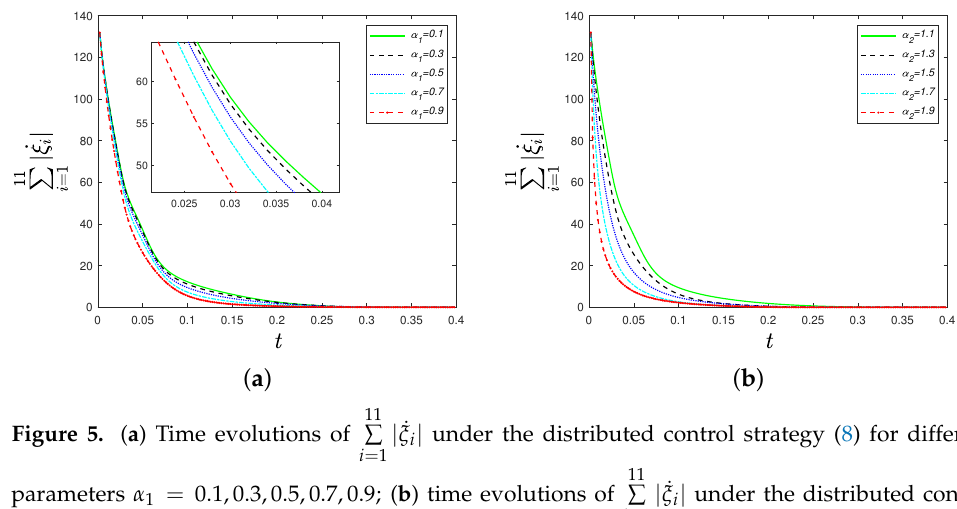
11 ∑ | ˙ ξ | under the distributed control i i = 1